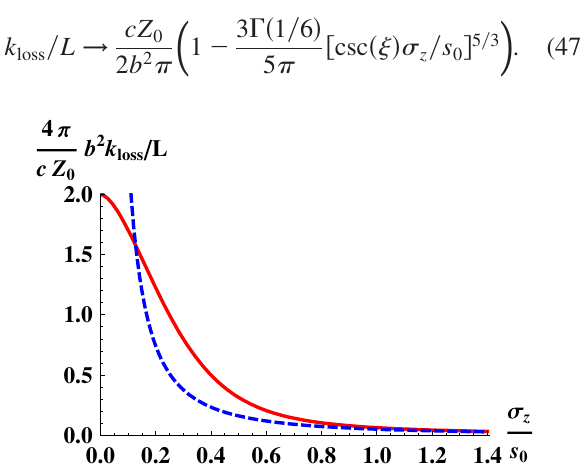
FIG. 4. (Color) Loss factor given by Eq. (46) (solid) and long- range approximation from Eq. (27)